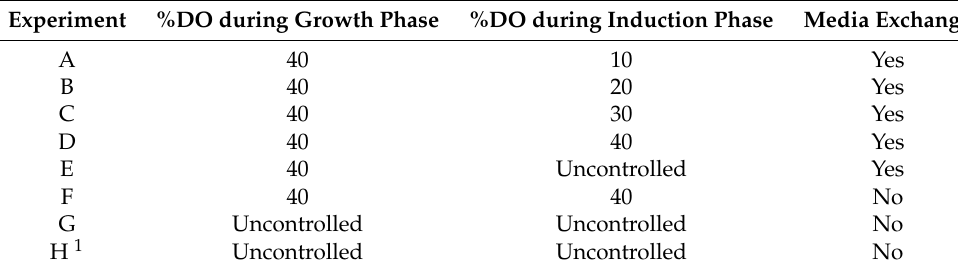
Table 4. Conditions used in bioreactor runs A–H where the agitation rate and temperature were maintained at 75 rpm and 27 °C, respectively, in all runs. The aeration rate was maintained at 0.2 vvm (volume of sparged gas per working volume per minute) in runs A–F and 0.2–0.4 vvm in runs G and H (reproduced from [11]). Experiment %DO during Growth Phase %DO during Induction